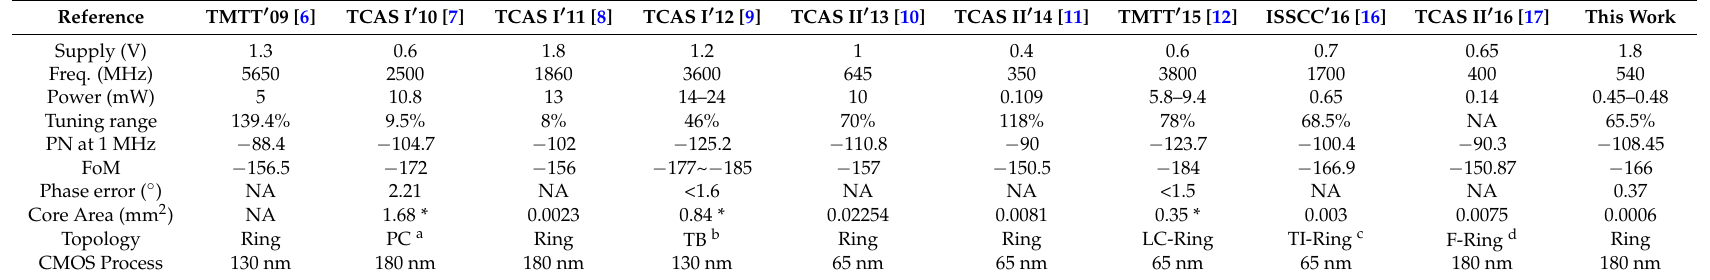
Table 1. Comparison of